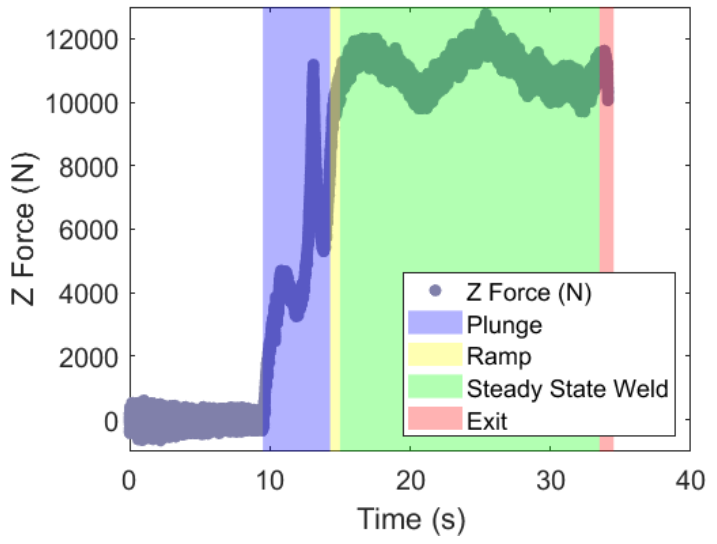
Figure 5. The green area represents the data truncation used in this study. The plot includes only the Z axis force from a weld that was produced with parameter set 1 in Table